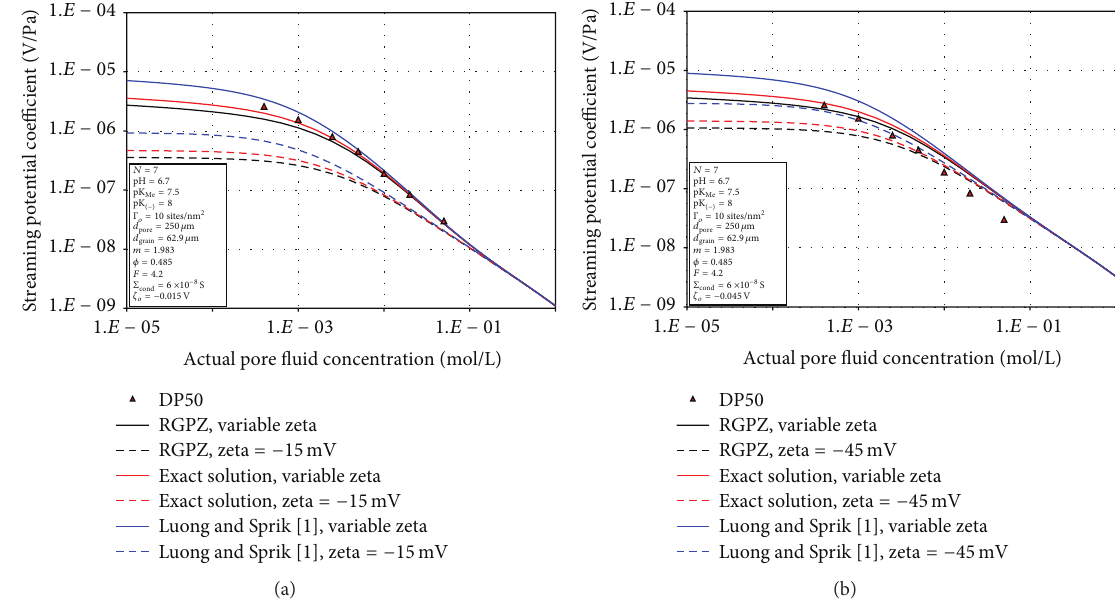
Figure 1: A comparison of the three equations for modelling streaming potential coefficient using a variable zeta potential calculated with Revil et al.’s [9] approach (solid lines) and constraining the zeta potential to a constant value equal to (a) − 15mV (dashed lines) and (b) − 45mV (dashed lines), pH = 6.77. Protonic surface conduction Σ prot 𝑠 = 6 × 10 −8